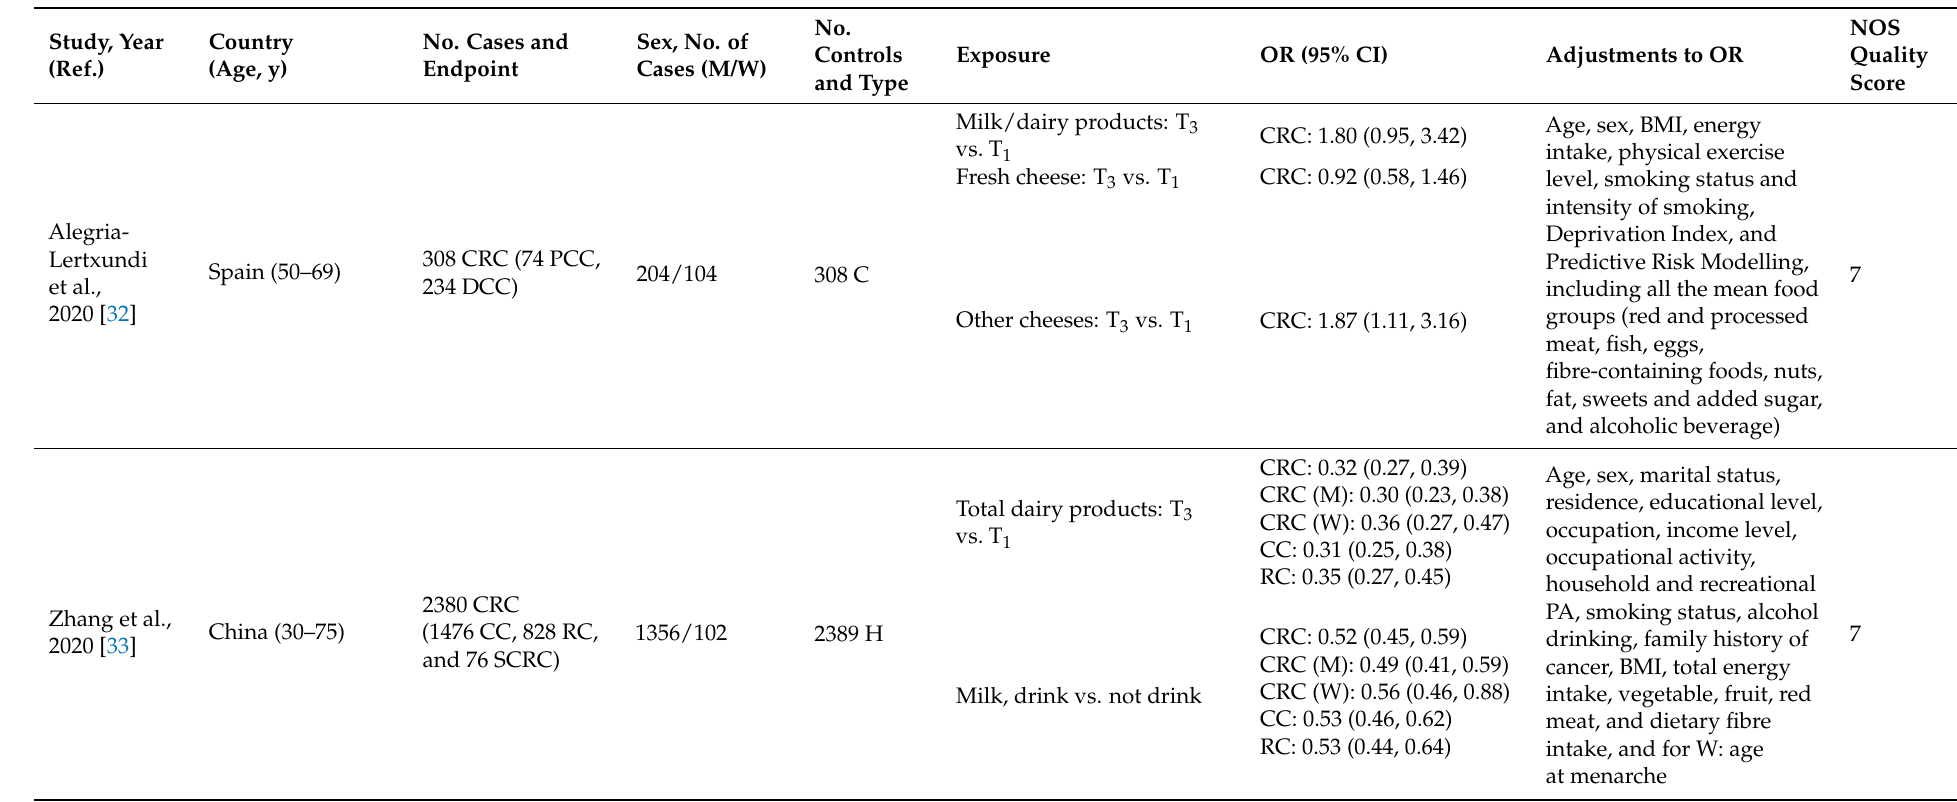
Table 2. Characteristics of the three case–control studies included in the systematic review examining the association between the consumption of dairy products and the risk of colorectal